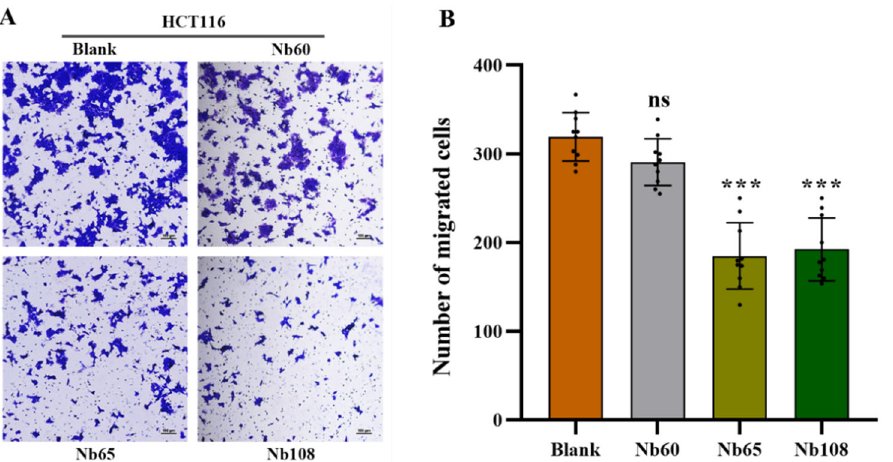
Nb60, whereas this without significant difference (Figure 6).